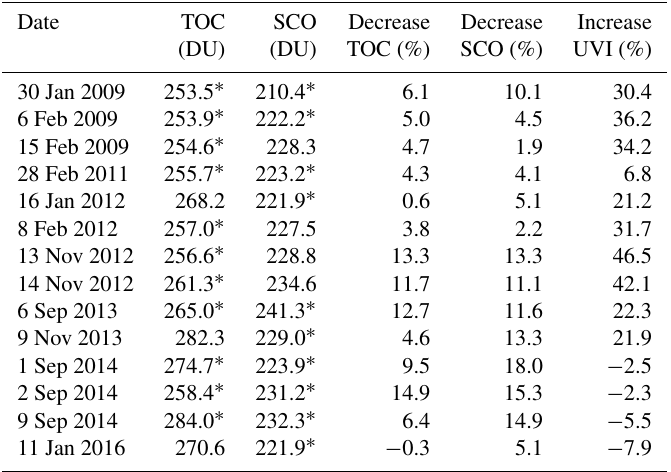
Table 2. Identified low-ozone events on clear-sky days at Cape Point during spring and summer months and the percentage decrease calcu- lated from the relative climatological monthly mean. Date TOC SCO Decrease Decrease Increase